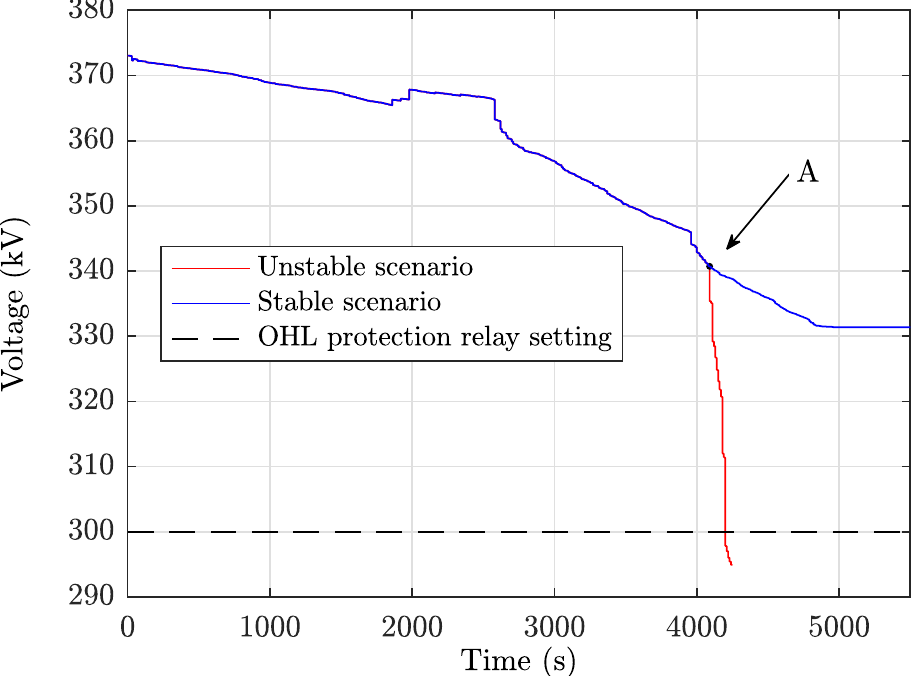
Figure 4. Voltage response at EHV bus 620 (Koumoundourou). Point A: sudden loss of Aliveri III